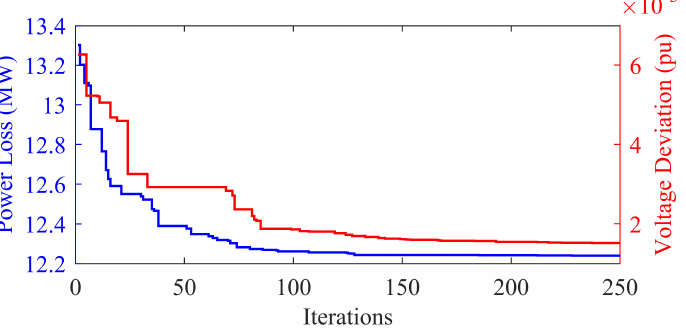
Figure 6. Convergence curves of P loss and V dev for the IEEE 14 bus test system optimized using the proposed